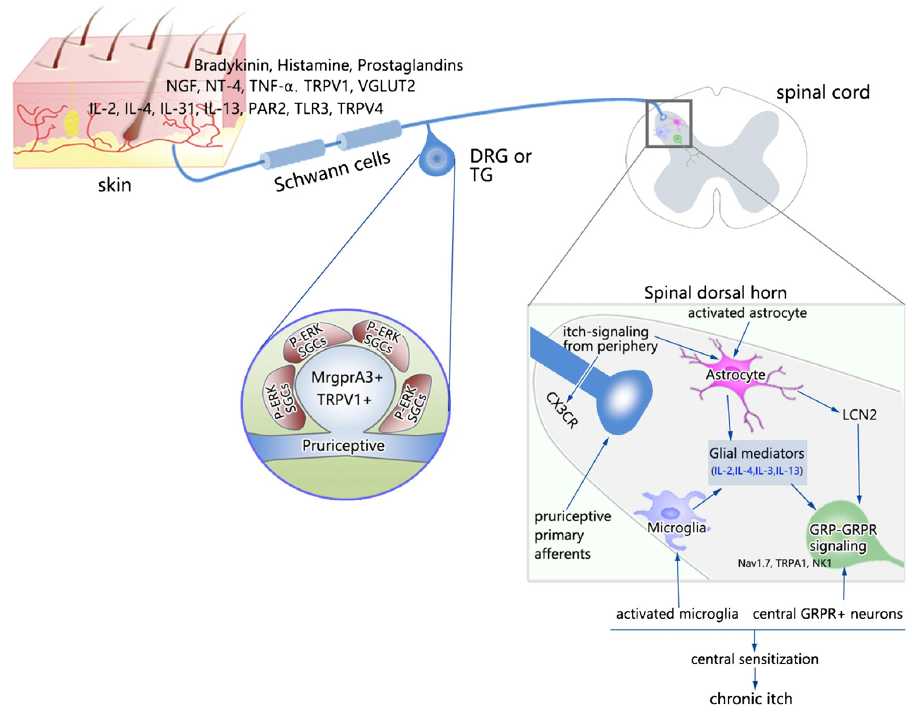
Figure 1. Peripheral and central mechanisms of sensitization of itch processing.